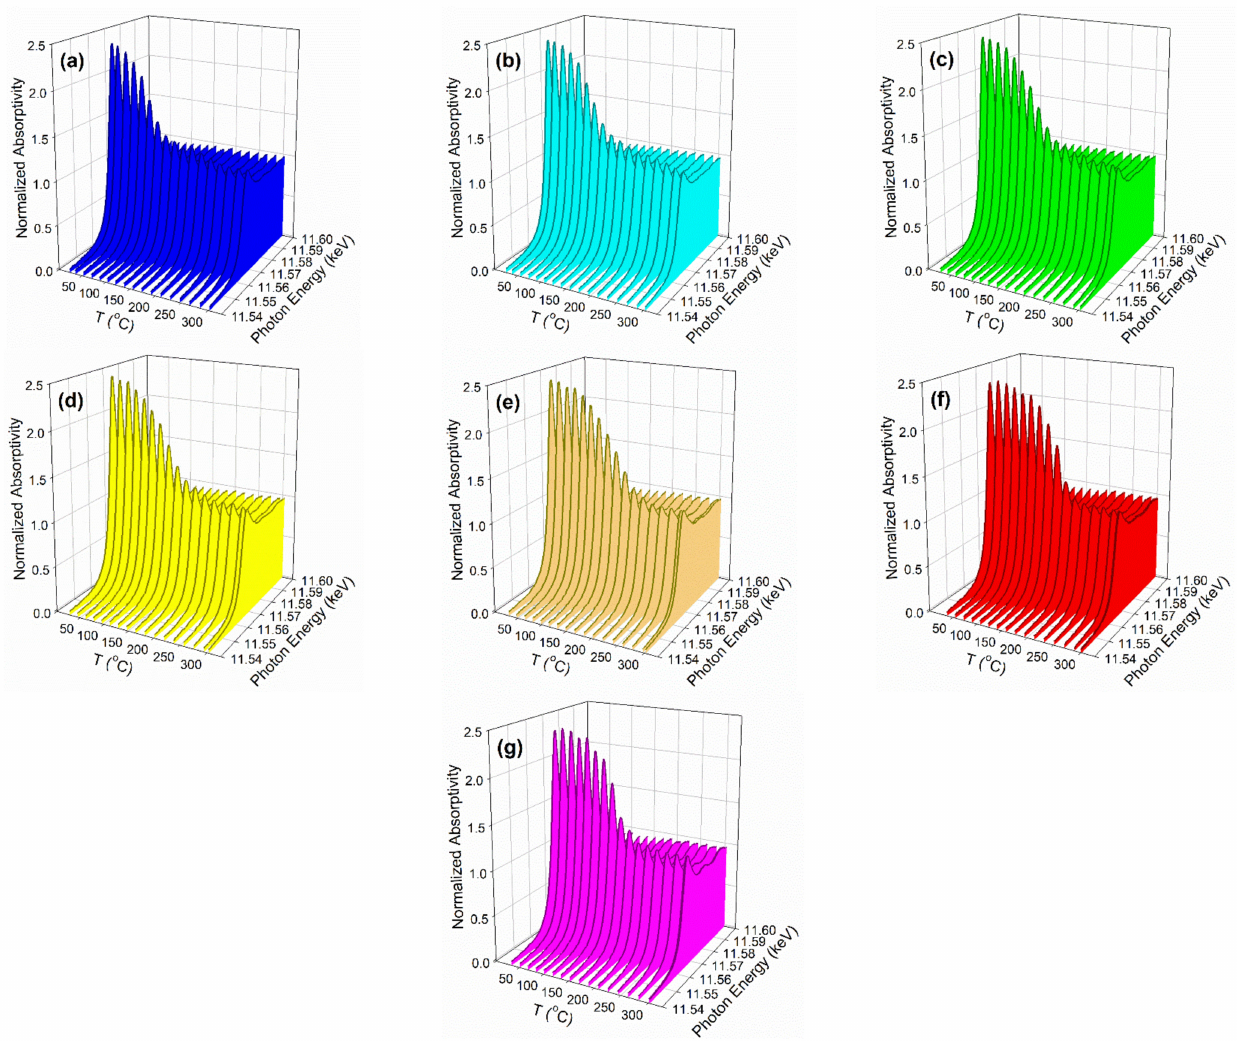
Figure 9. TPR-XANES spectra at the Pt L-3 edge of ( a ) 2%Pt/ZrO 2 , ( b ) 0.93%Rb-2%Pt/ZrO 2 , ( c ) 1.86%Rb-2%Pt/ZrO 2 , ( d ) 2.79%Rb-2%Pt/ZrO 2 , ( e ) 4.65%Rb-2%Pt/ZrO 2 , ( f ) 5.58%Rb-2%Pt/ZrO 2 , and ( g ) 9.29%Rb-2%Pt/ZrO 2